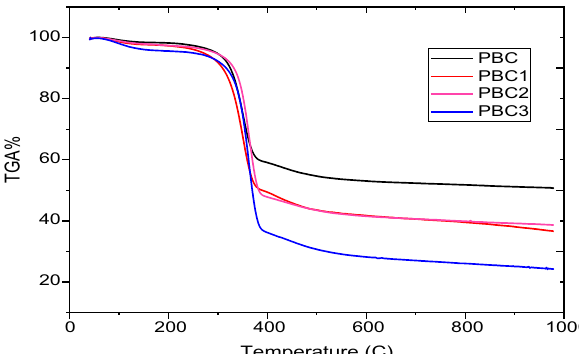
Figure 6. TGA thermograph results of obtained BC using different regimes of cultivation, including HS (PBC), JCP (PBC1), ECPS (PBC2), and EPC (PBC3)